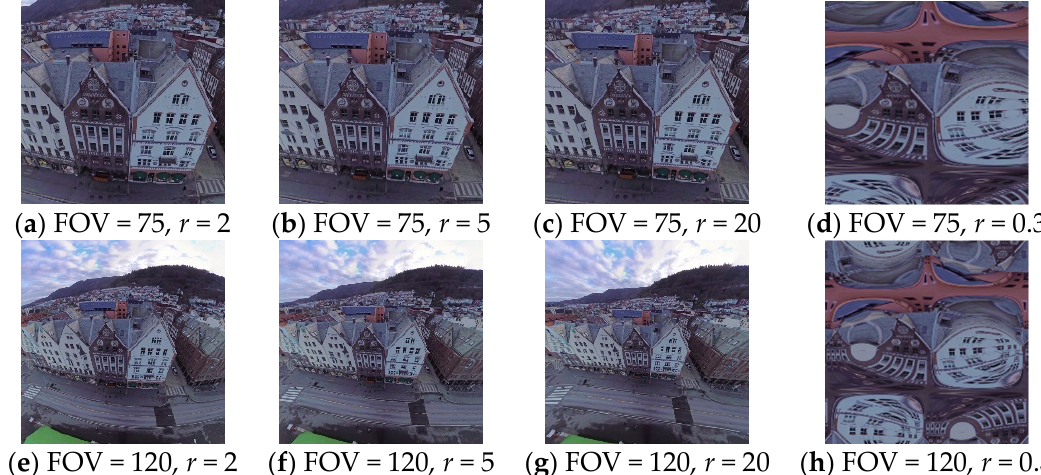
Figure 10. Cross-section of the proposed UV surface and the unit sphere. Figure 11 displays the VPs that occur from applying the curved UV surface for the FOV = {75, 120} and (cid:1870) = {2, 5, 20, 0.3}, where a larger outer sphere produces flatter straight lines. When (cid:1870) is set to 0.3, the generated viewports degrade significantly, because (cid:1870) = 0.3 is included in the range of instability in Equation (31).